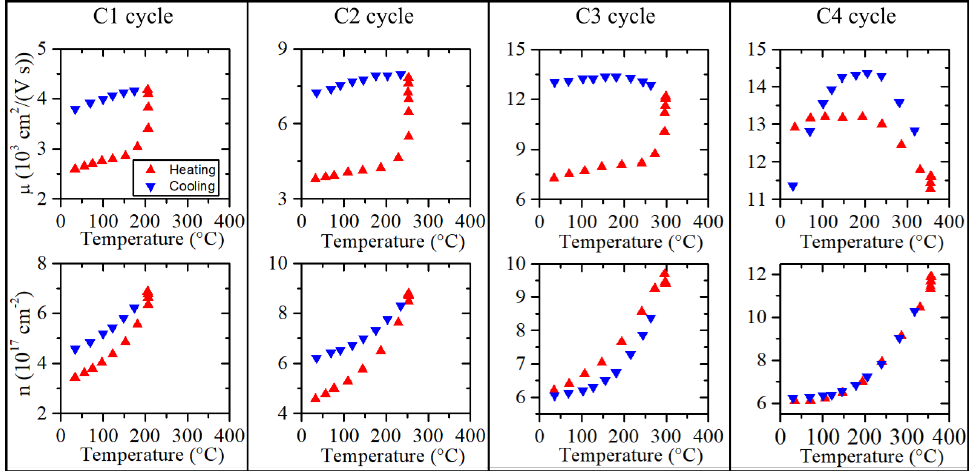
Figure 3. Complete temperature treatment process of the I6 structure.